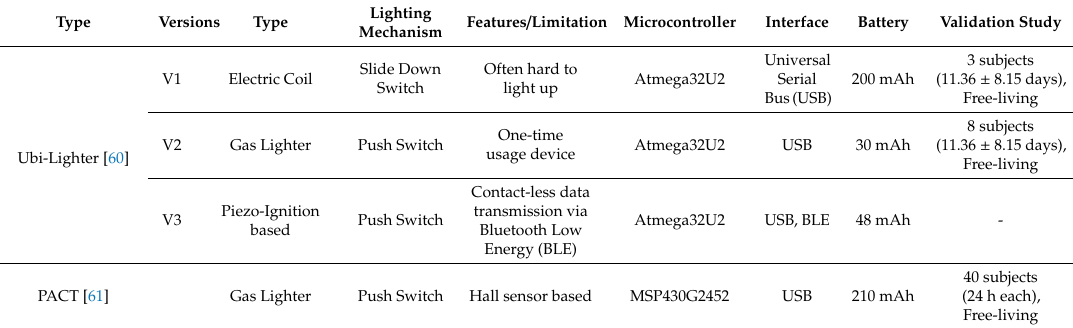
Table 4. A summary of instrumented lighters employed to detect cigarette lighting